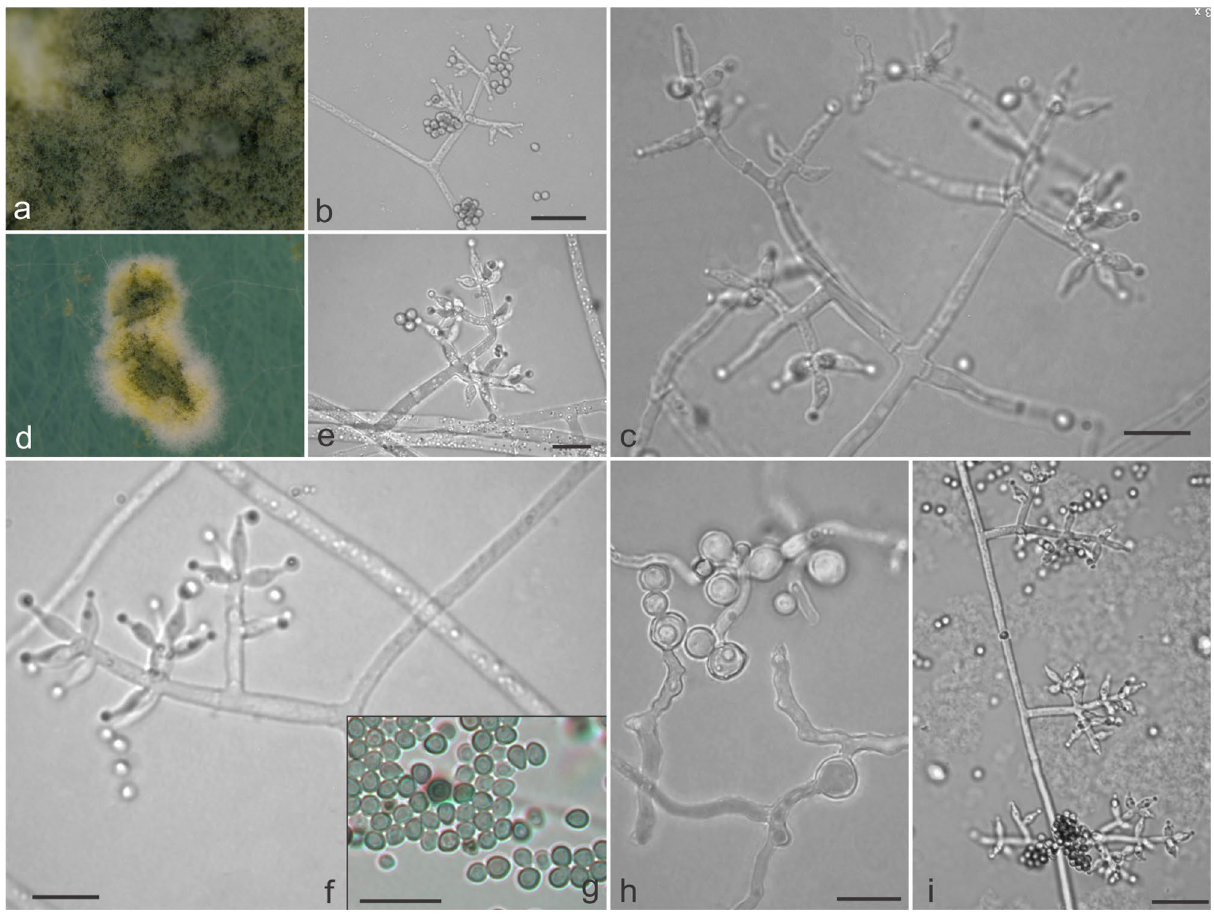
Figure 12. Morphological features characteristic of Trichoderma pseudopyramidale sp. nov. (COAD 2426). ( a , d ) Stereo microscope images on SNA. ( b , c , e , f , i ) Conidiophores and phialides formed on SNA. ( h ) chlamydospores on CMD. ( g ) Conidia. Bars: ( e , c , f , h ) = 10 µm; ( b , i ) = 20